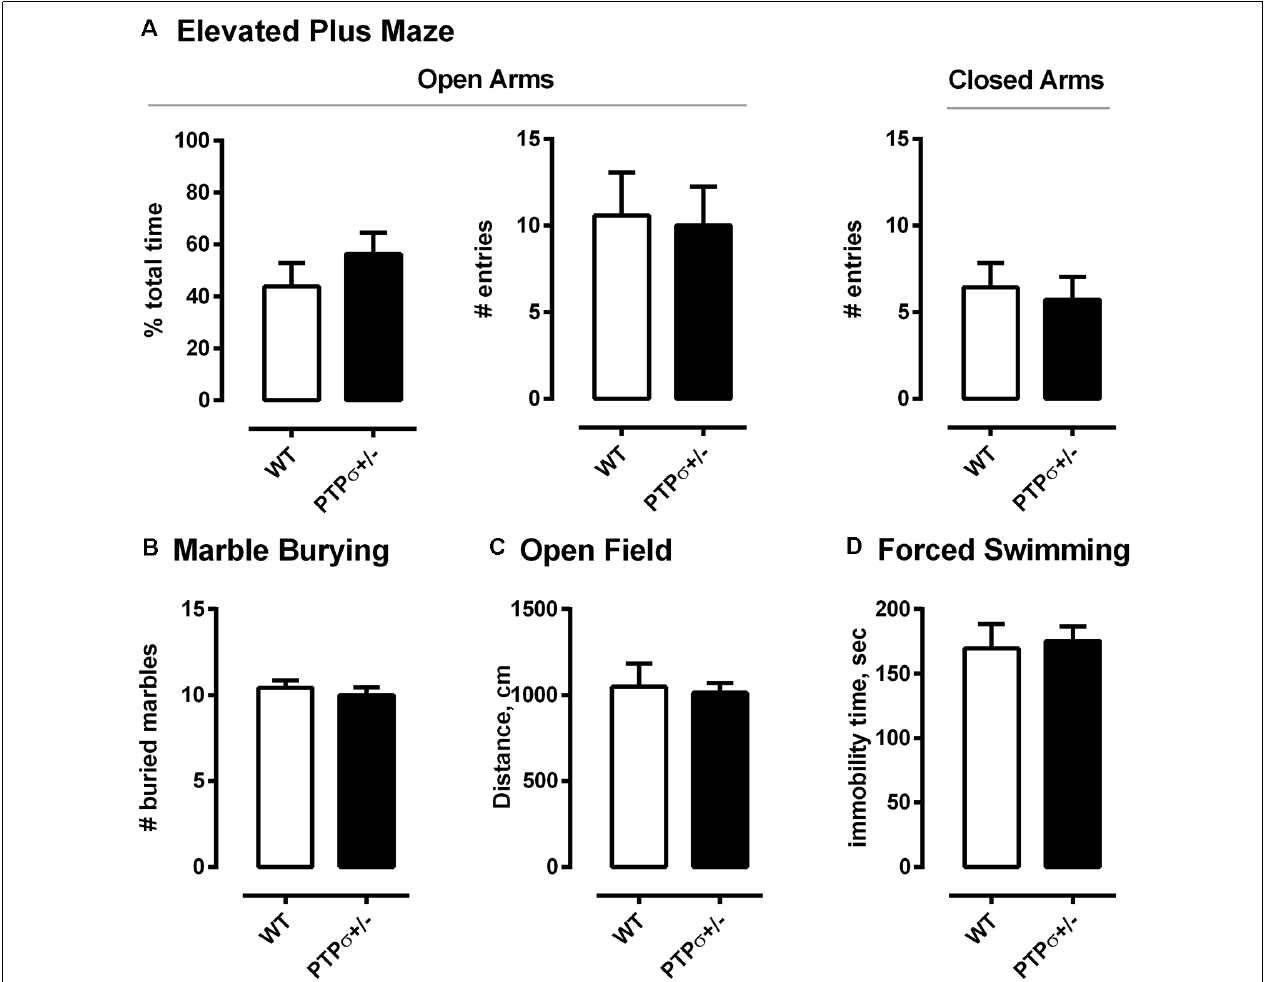
FIGURE 3 | PTP σ + / − mice exhibit normal behavior in tests that do not involve cognitive flexibility. PTP σ + / − mice display no behavioral changes in (A) elevated plus maze, (B) marble burying, (C) open field, and (D) forced swimming tests as compared to their wild-type littermates. Data were analyzed by t -test ( A total time, C,D ) or by Mann–Whitney test ( A , # entries for Open and Closed Arms, and B